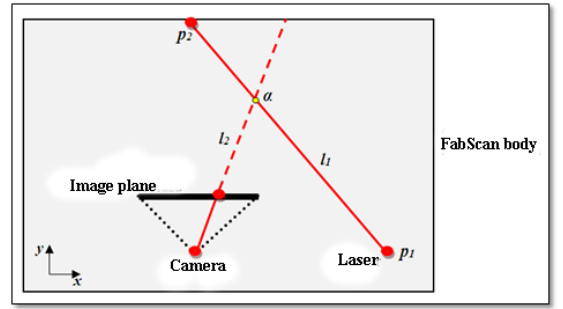
Figure 4. Intersection of the beams inside the scanner (2D